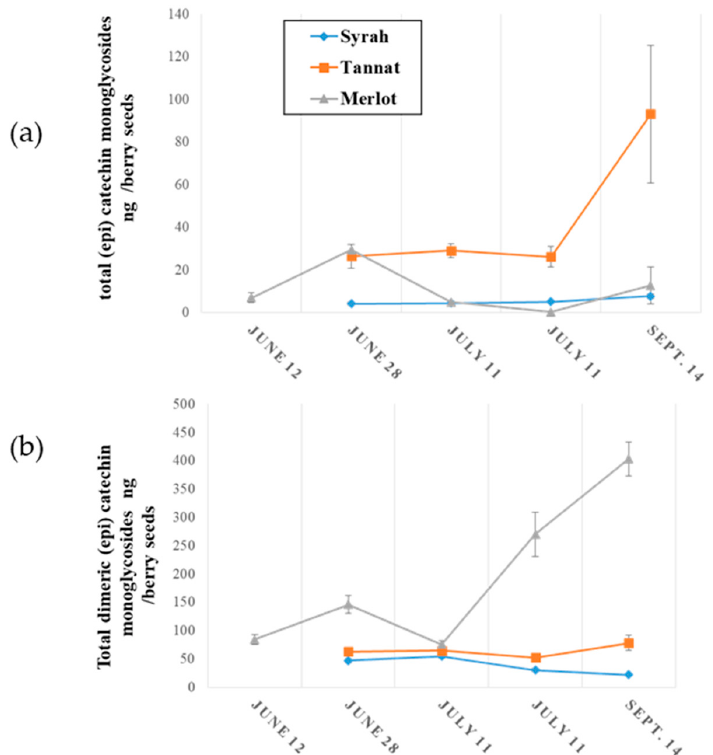
Figure 4. Evolution of ( a ) monomeric (epi) catechin monoglycosides and ( b ) dimeric (epi) catechin monoglycosides during grape seed ripening.